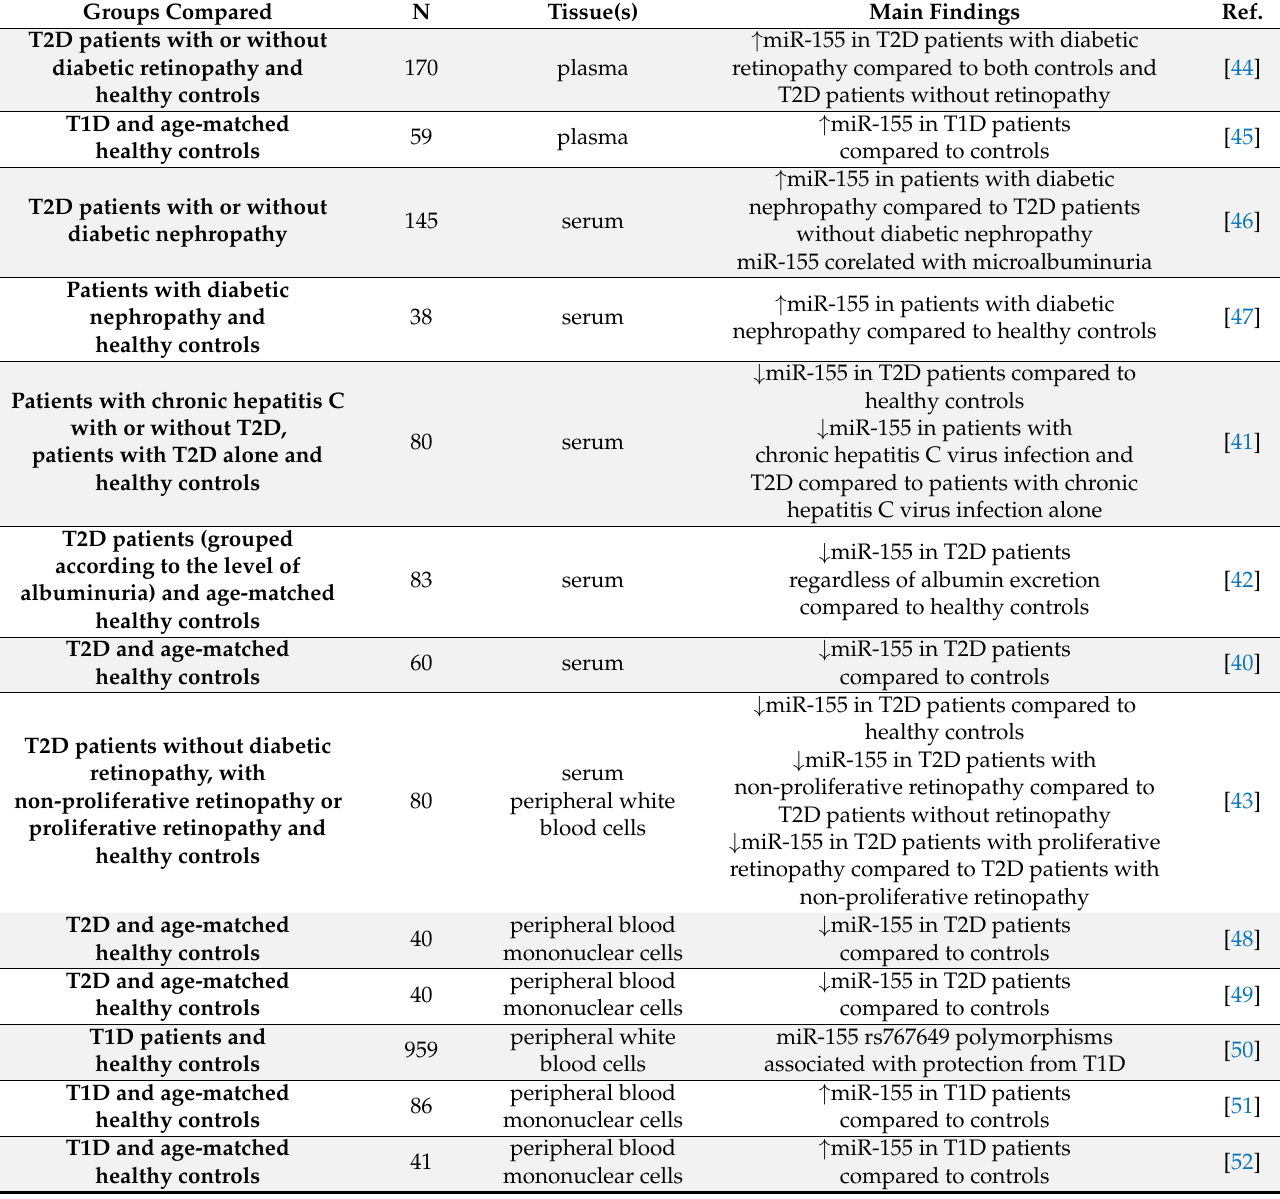
Table 1. List of clinical studies examining the association between miR-155 dysregulation and T1D or T2D and their complications. The studies investigating circulating levels of miR-155 are positioned at the top of the table, whereas the studies investigating tissue levels of miR-155 are at the bottom of the table. ↑ : upregulation, ↓ : downregulation. Groups Compared N Tissue(s) Main Findings Ref. T2D patients with or